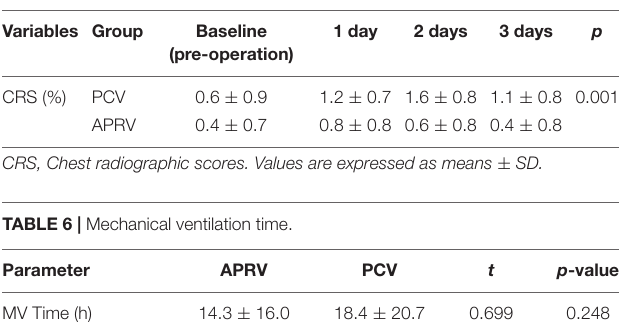
TABLE 5 | Chest radiograph score (CRS).